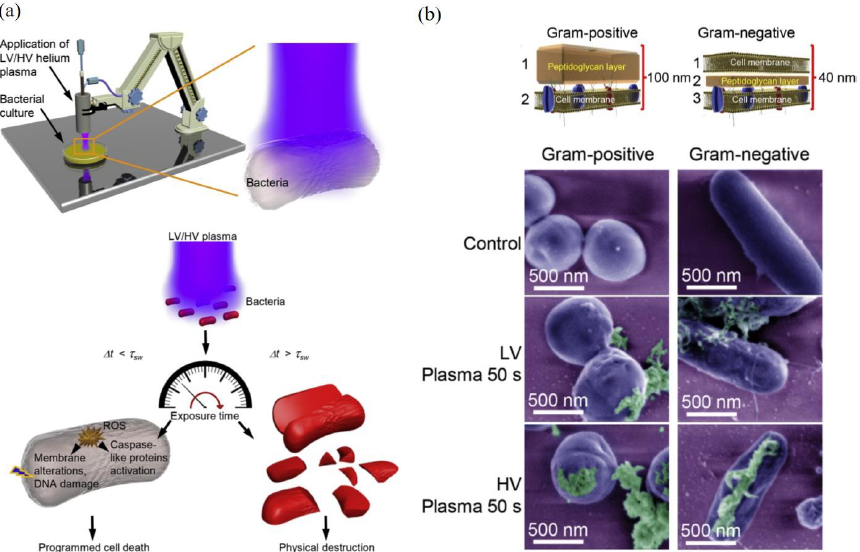
Figure 6. The cell death of bacteria after CAP treatment. ( a ) The interplay of physical destruction and biological cell death upon CAP treatment. ( b ) False-colored SEM images of bacteria exposed to CAP with high discharge voltage (HV) and low discharge voltage (LV) [149].